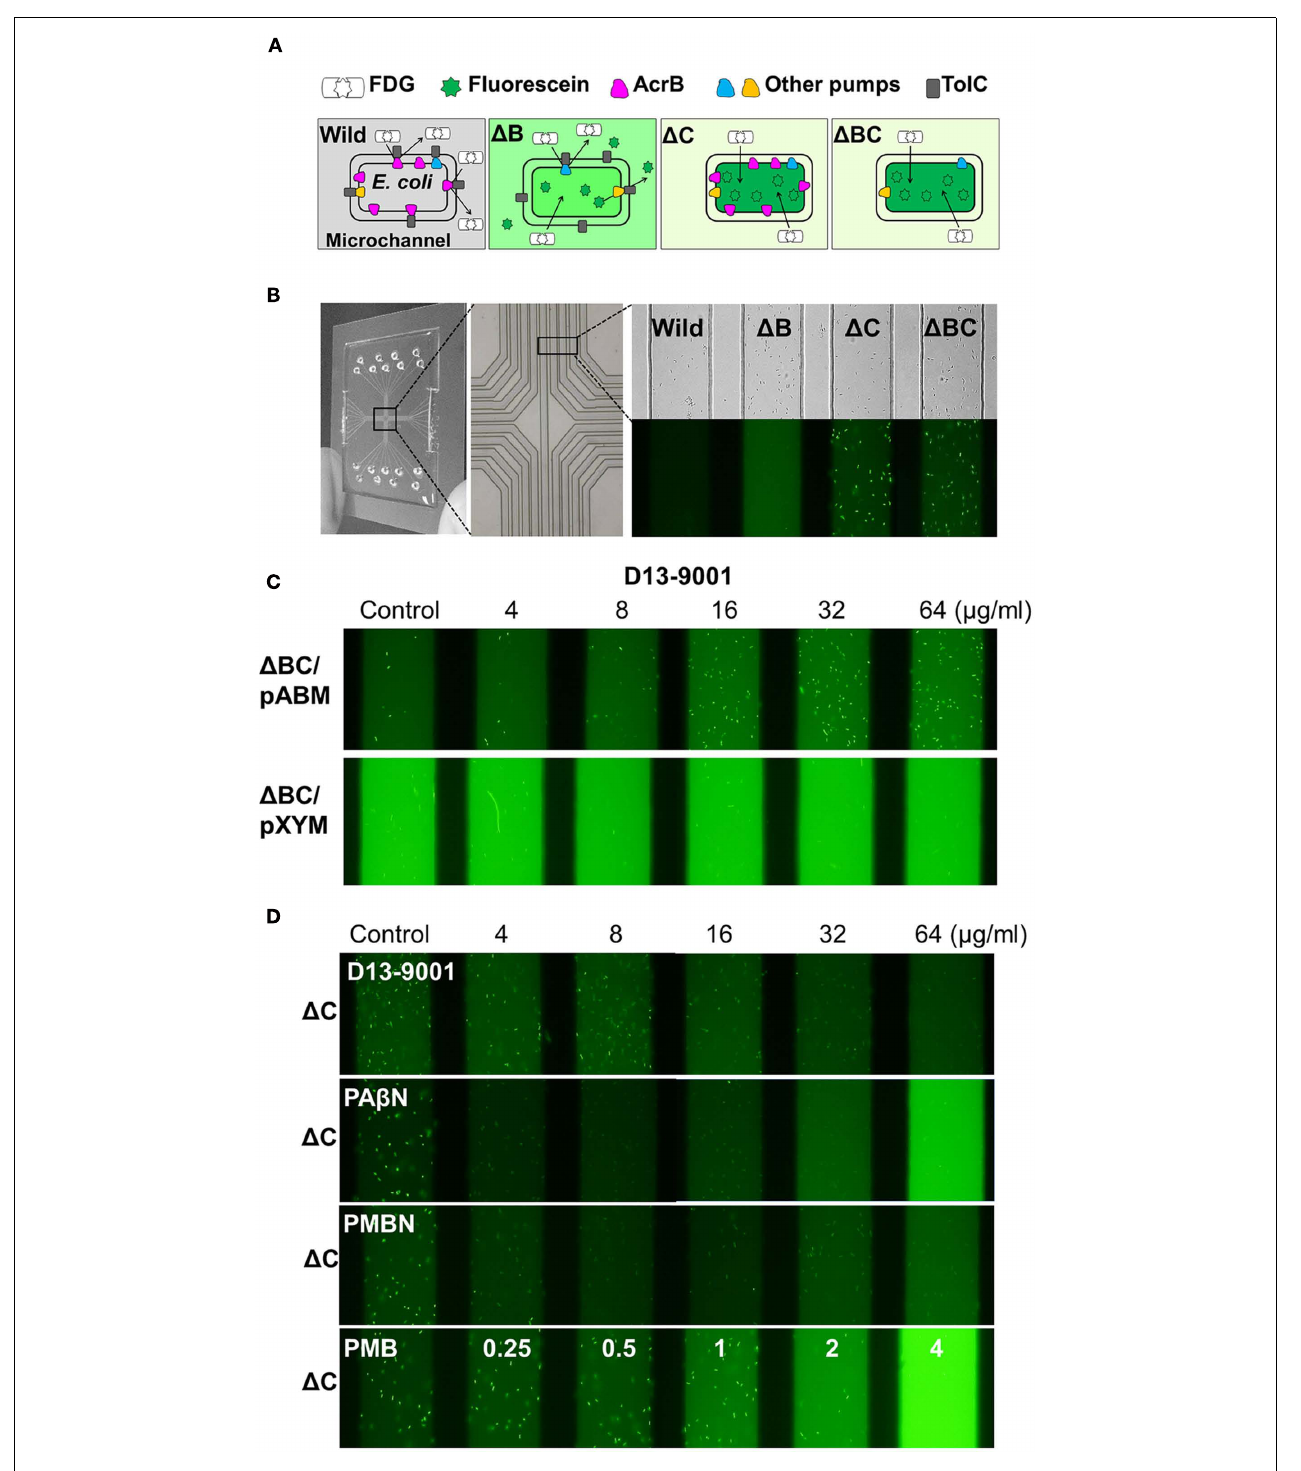
Δ acrB Δ tolC ( Δ BC) cells. (C) Fuorescence images of the Δ acrB Δ tolC /pABM ( Δ BC/pABM), Δ acrB Δ tolC /pXYM ( Δ BC/pXYM) cells treated with different concentrations of D13-9001. (D) Fluorescence images of the E. coli Δ tolC cells treated with different concentrations of D13-9001, PA β N, PMBN, and polymyxin B. Modified from Matsumoto et al.